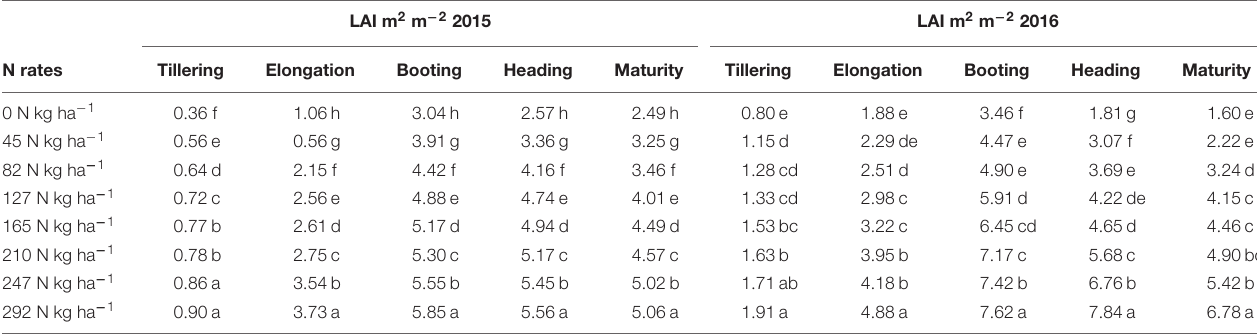
TABLE 2 | Description of Oryza sativa L. leaf area index (LAI) at phenological stages under different nitrogen rates.